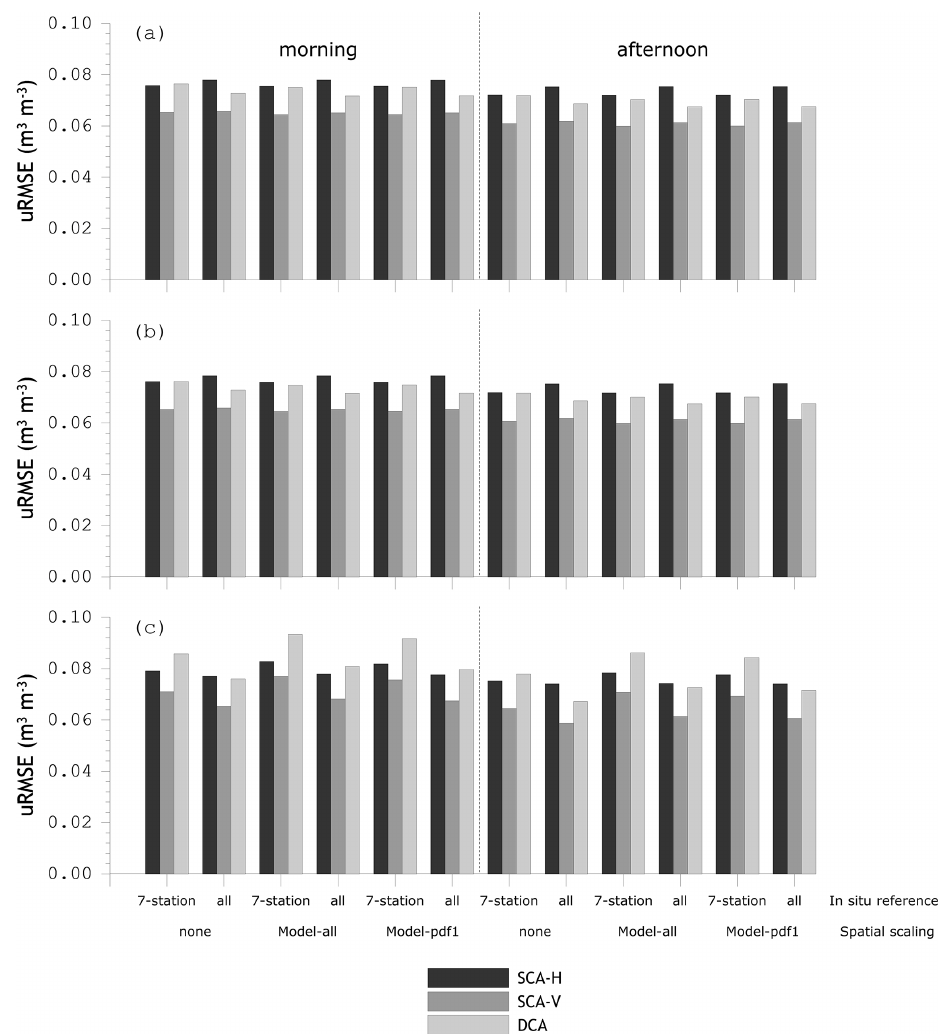
Figure 11. Unbiased root mean squared error (uRMSE) computed between SMAP soil moisture retrieved and in situ references; (a) the metrics for reference pixel 3306, (b) for reference pixel 3606, and (c) for reference pixel